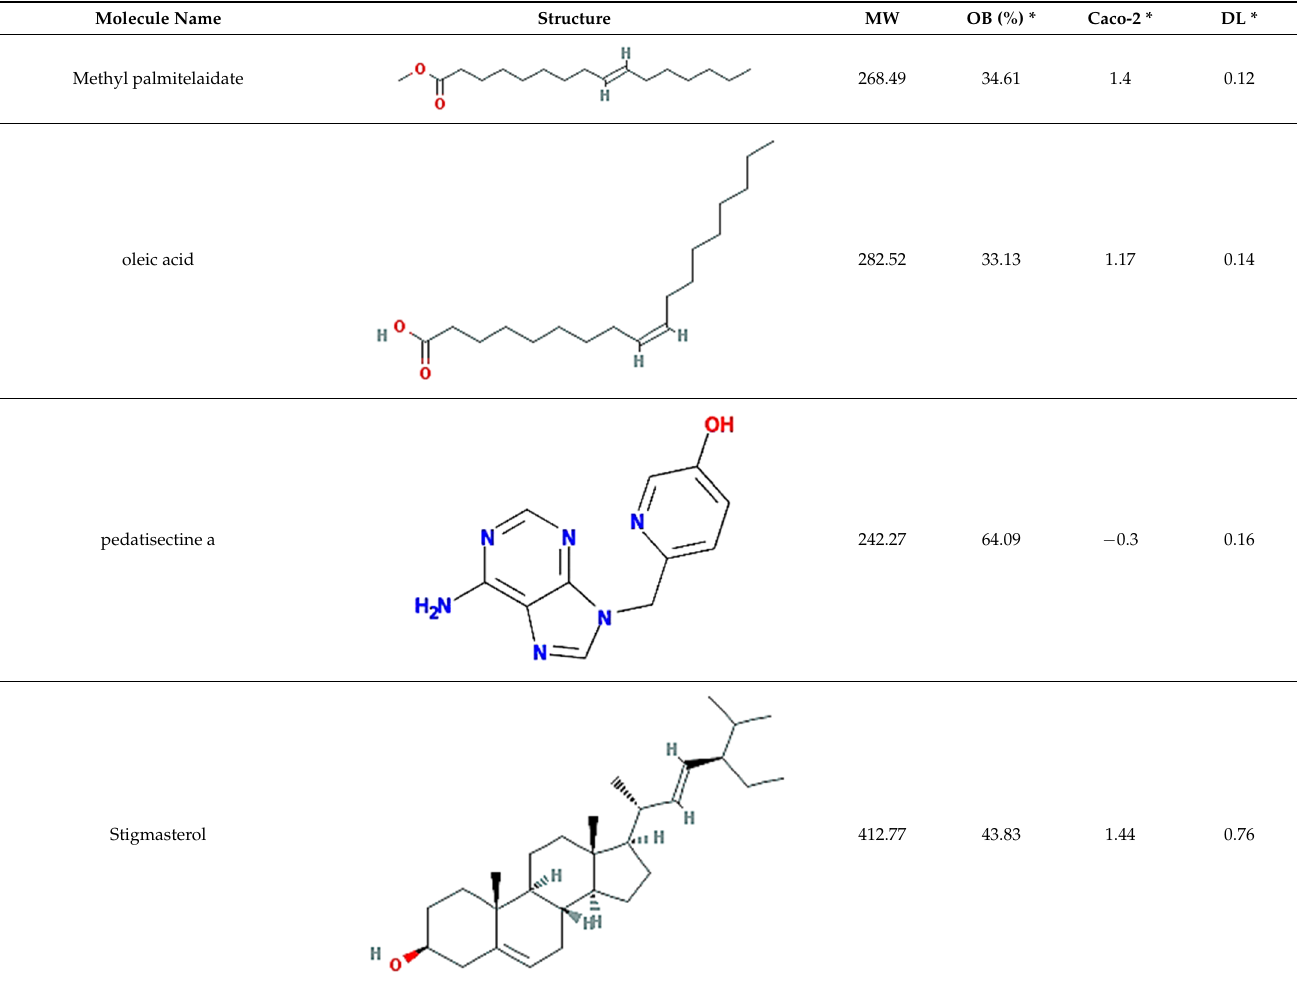
Table 2. Compounds and targets related to gastrointestinal (GI) disease.